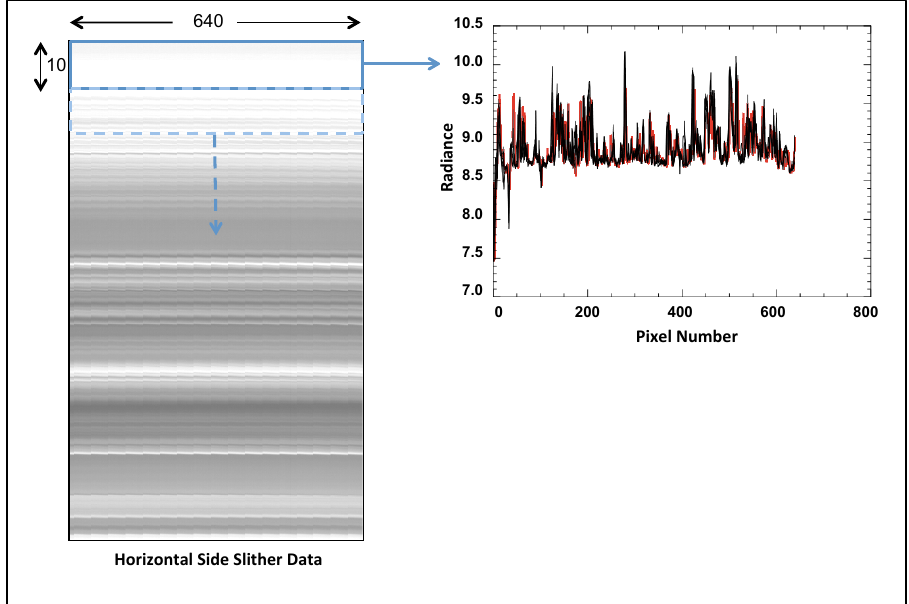
Figure 6. Illustration of automated processing method to find regions of lowest variability in the side slither